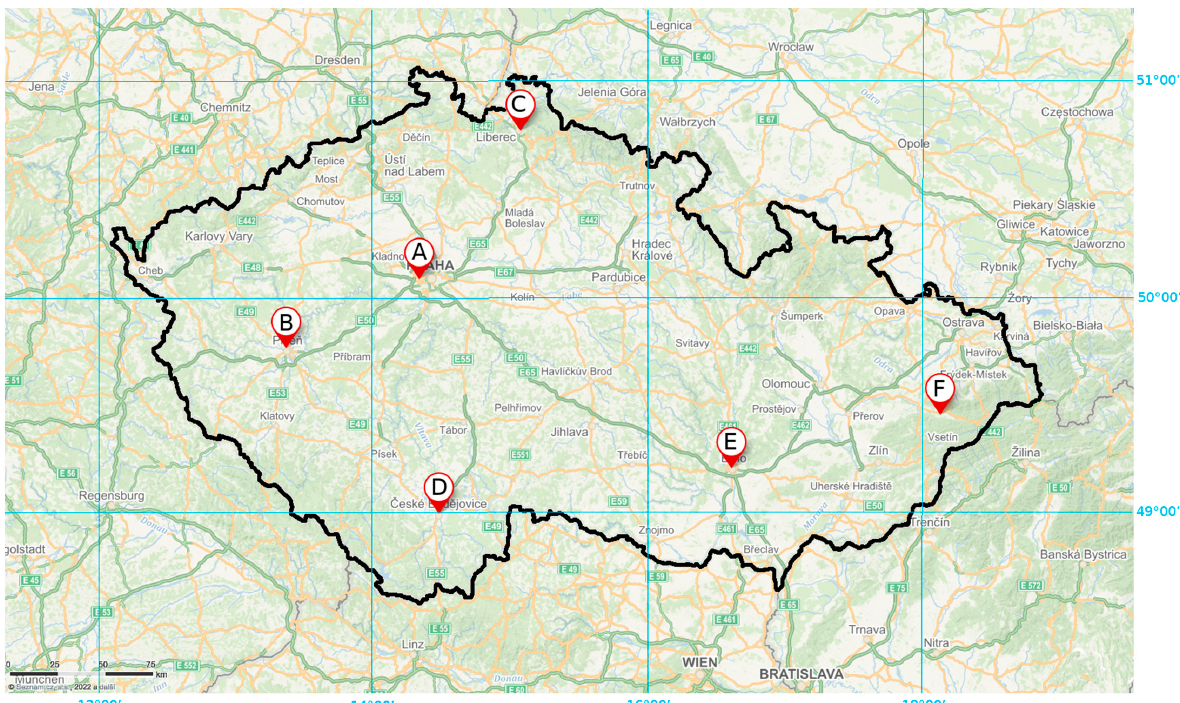
Figure 1. The map of the Czech Republic with marked sites where Aesculus hippocastanum leaf samples were collected. Source: Mapy.cz. Table 1. Characteristics of the sampling sites.